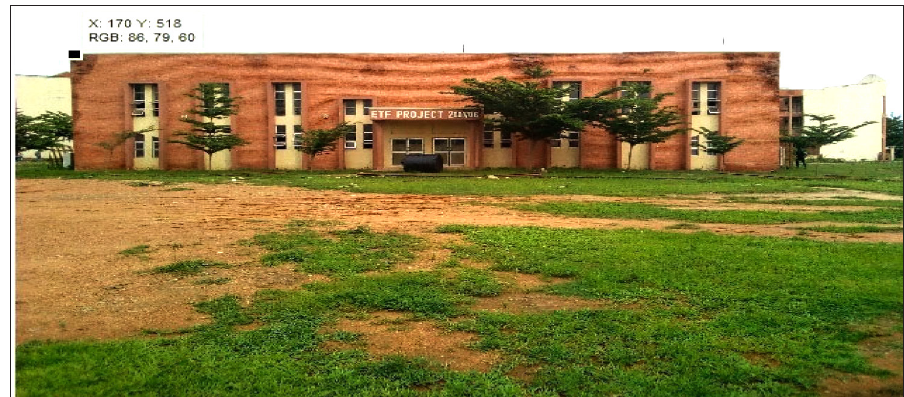
Figure 3. Pixel extraction in the MATLAB